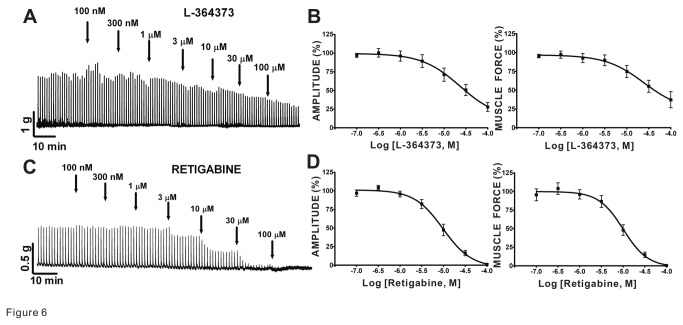
Kv7 channel activators, L-364373 and retigabine, induced inhibition of the 10 Hz EFS-evoked contractions in guinea pig DSM isolated strips.
A) This original DSM tension recording illustrates L-364373 inhibitory effects on DSM 10 Hz EFS-induced contractions. B) Cumulative concentration-response curves for L-364373 summarize inhibitory effects on the amplitude and muscle force of EFS-induced contractions (n=6, N=4). C) This original DSM tension recording depicts an effect of retigabine on contractions induced by EFS (10 Hz). D) Cumulative concentration-response curves for retigabine demonstrate reduction of 10 Hz EFS-induced DSM contraction amplitude and muscle force (n=9, N=8). Table 2 summarizes the potency and maximum efficacy values.